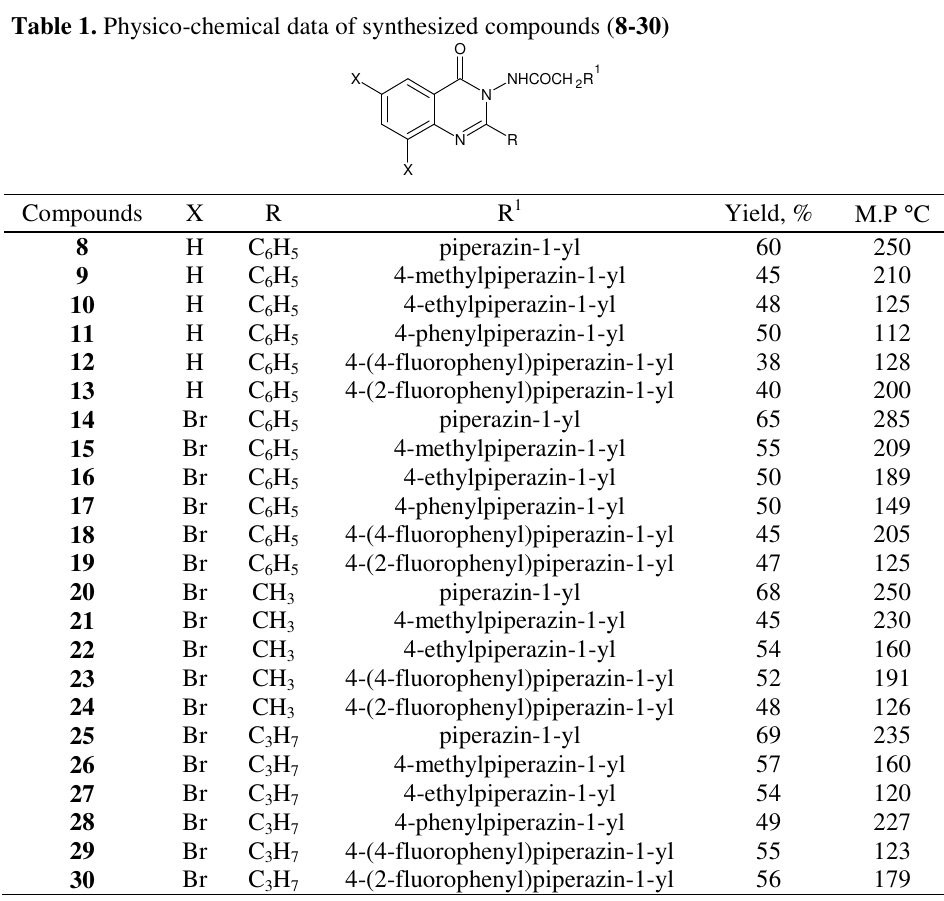
Table 1. Physico-chemical data of synthesized compounds ( 8-30)